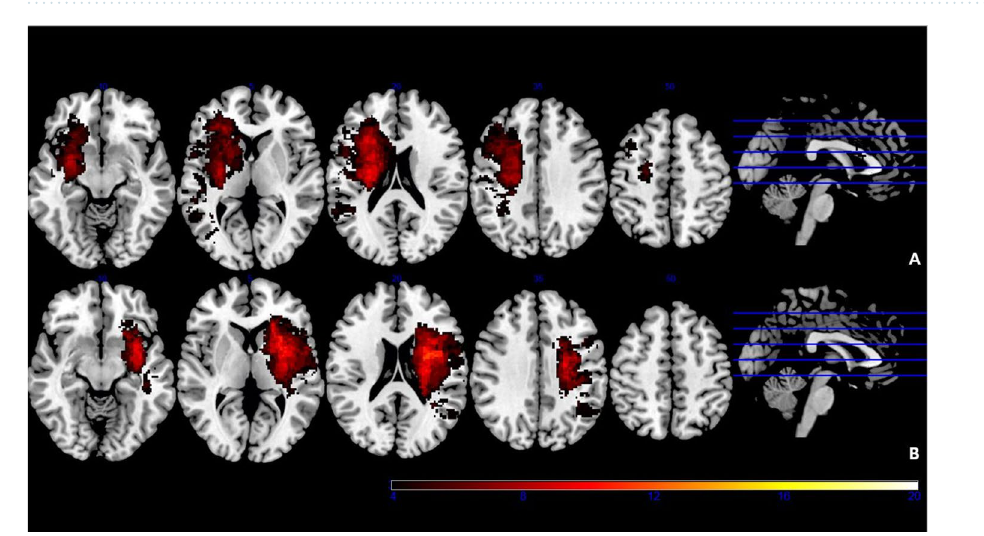
Figure 2. Lesion overlap plot of the poststroke CRPS group, with lesions in the right hemisphere (N = 18) ( A ) and left hemisphere (N = 17) ( B ). The colour bar represents the number of patients with lesions in that